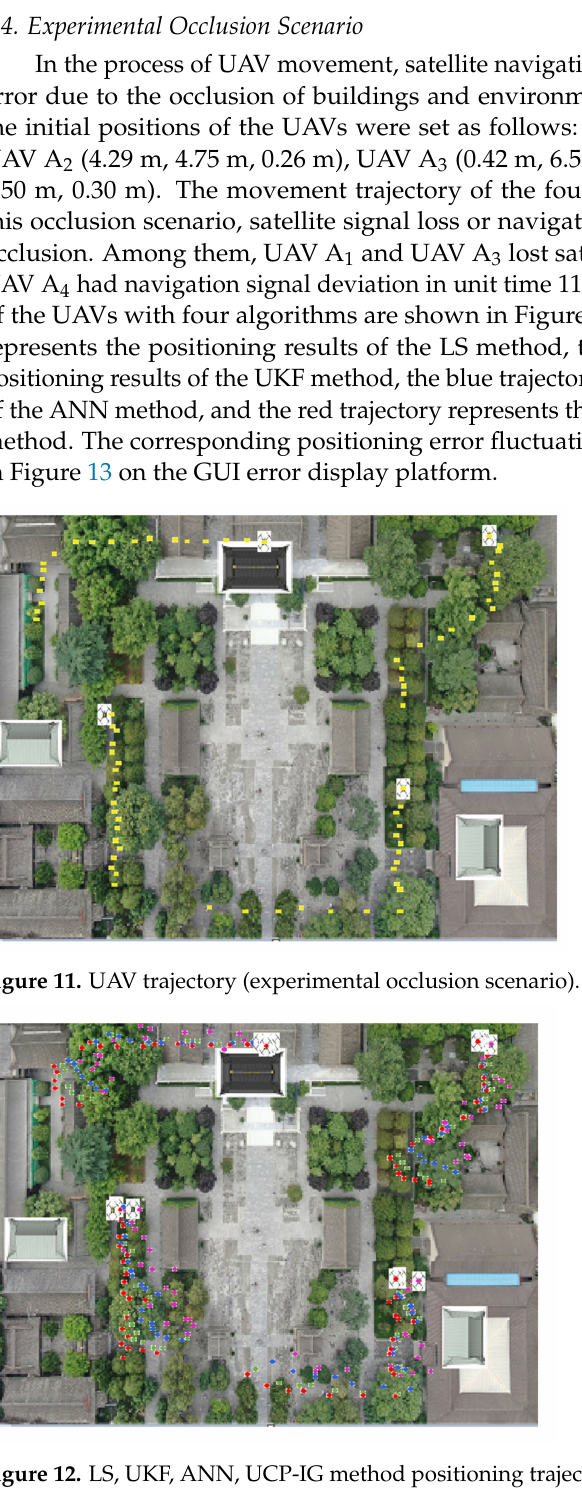
Figure 12. LS, UKF, ANN, UCP-IG method positioning trajectory (experimental occlusion